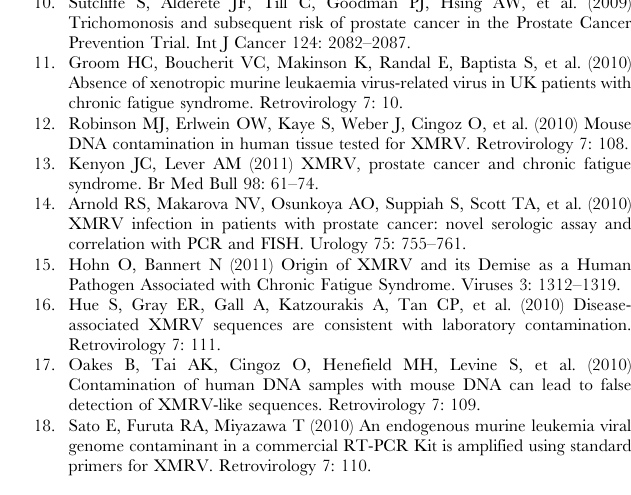
Table S1 Full nucleic acid detection results.